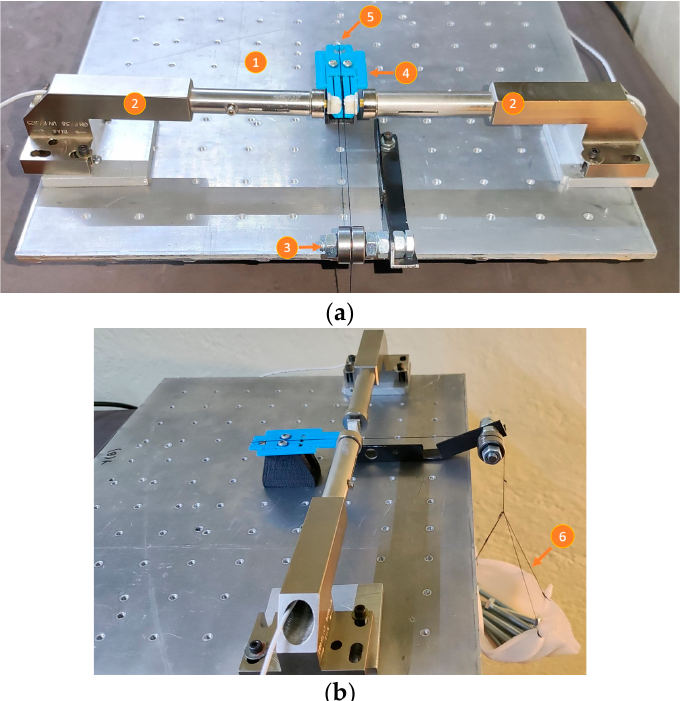
Figure 15. ( a ) Experimental setup to characterize the jaw displacement with the input force. ( b ) An applied load.